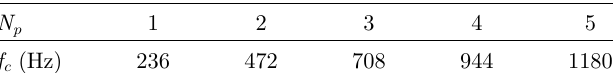
Table 1. Critical frequencies for the fi rst fi ve vibration patterns according to Equation (14).